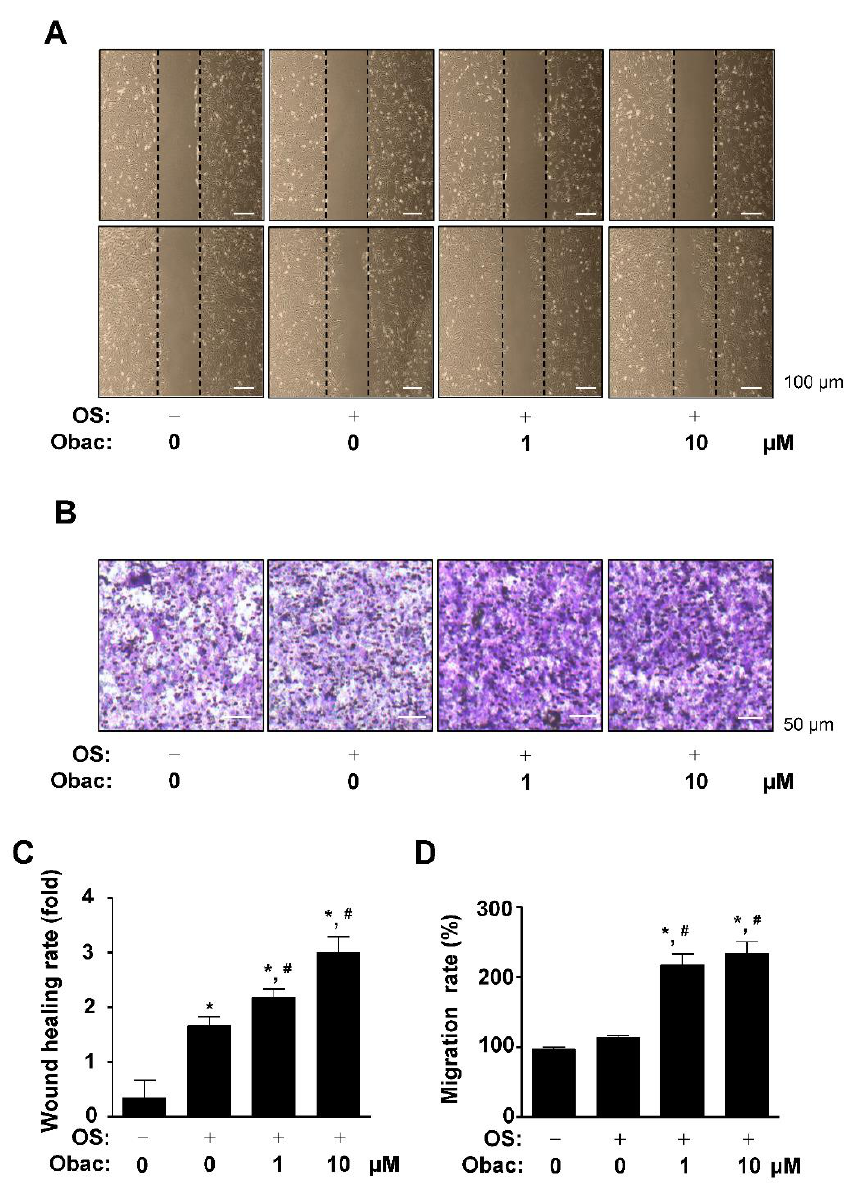
Figure 2. Effects of Obac on cell migration in osteoblast differentiation. ( A , C ) MC3T3-E1 was cultured in osteogenic supplement medium (OS) in the absence or presence of Obac (1–10 µ M) for 24 h. Cell migration was observed under a phase contrast microscope ( A ), and the cell migration rate (fold) was measured by the area enclosing the spreading cell population and expressed as a bar graph ( C ). ( B , D ) The Boyden chamber assay was performed and observed under a phase contrast microscope ( B ), and migration rate (%) was normalized to the control and expressed as a bar graph ( D ). Data are representative of three independent experiments, and values are expressed as the mean ± S.E.M. * p < 0.05 indicates statistically significant differences, compared with the control. #: statistically significant differences compared with OS ( # p < 0.05).